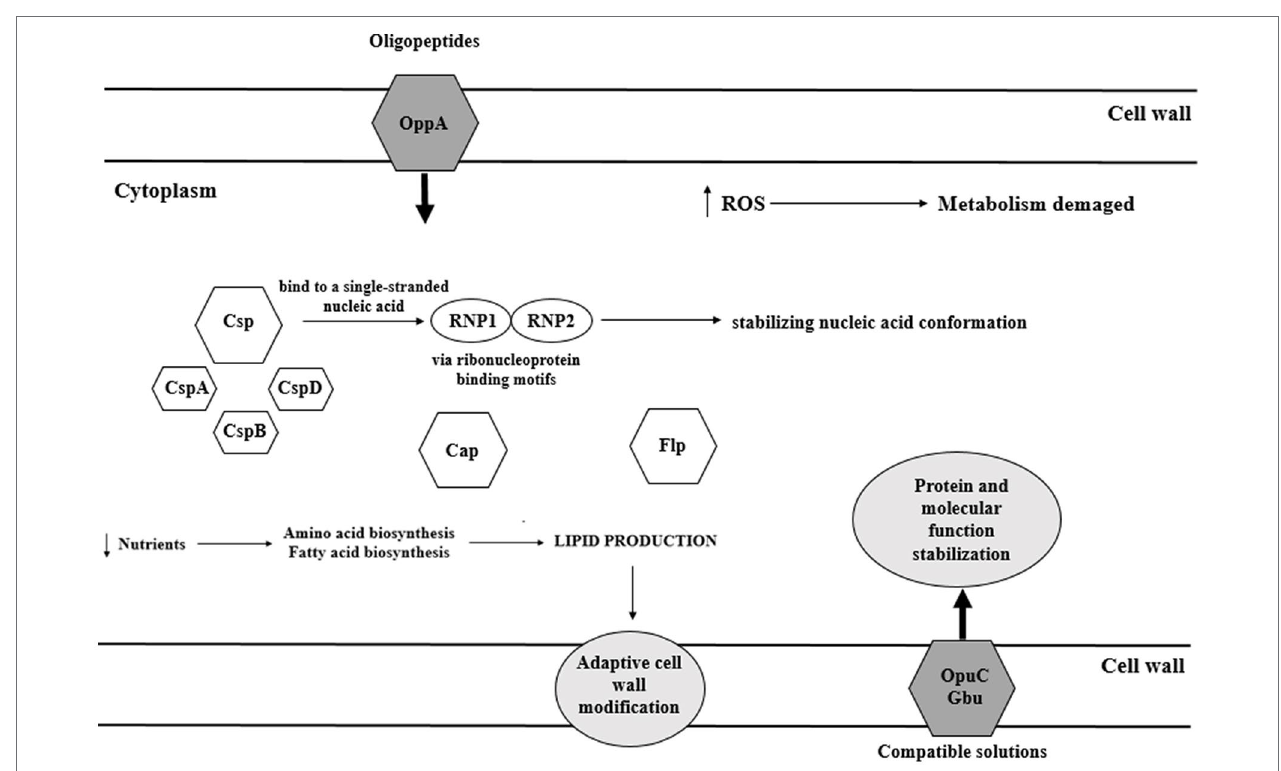
FIGURE 6 | Cold stress response of L. monocytogenes (OpuC – ATP-dependent carnitine transporter; Gbu – glycine betaine; ROS – reactive oxygen species; Csp – cold-shock protein; Cap – cold acclimatization protein; and Flp – ferritin-like